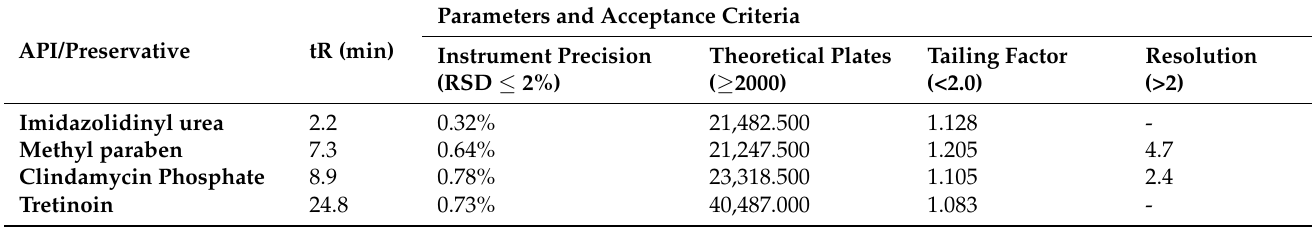
Table 1. System suitability studies of the pharmaceutical